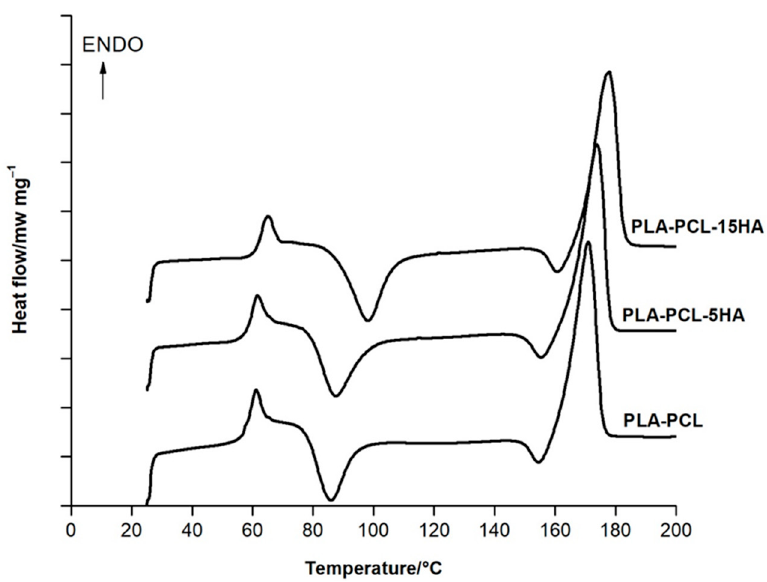
Figure 4. XRD patterns of ( a ) the locally extracted HA powder; ( b ) PLA/PCL, ( c ) PLA/PCL/5HA, and ( d ) PLA/PCL/15HA filaments.